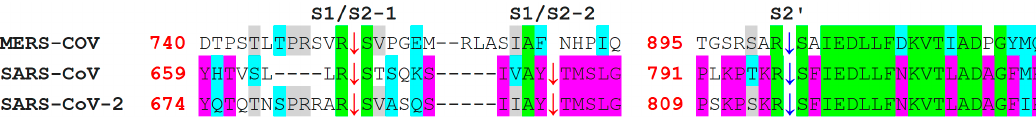
is identical between SARS-CoV and